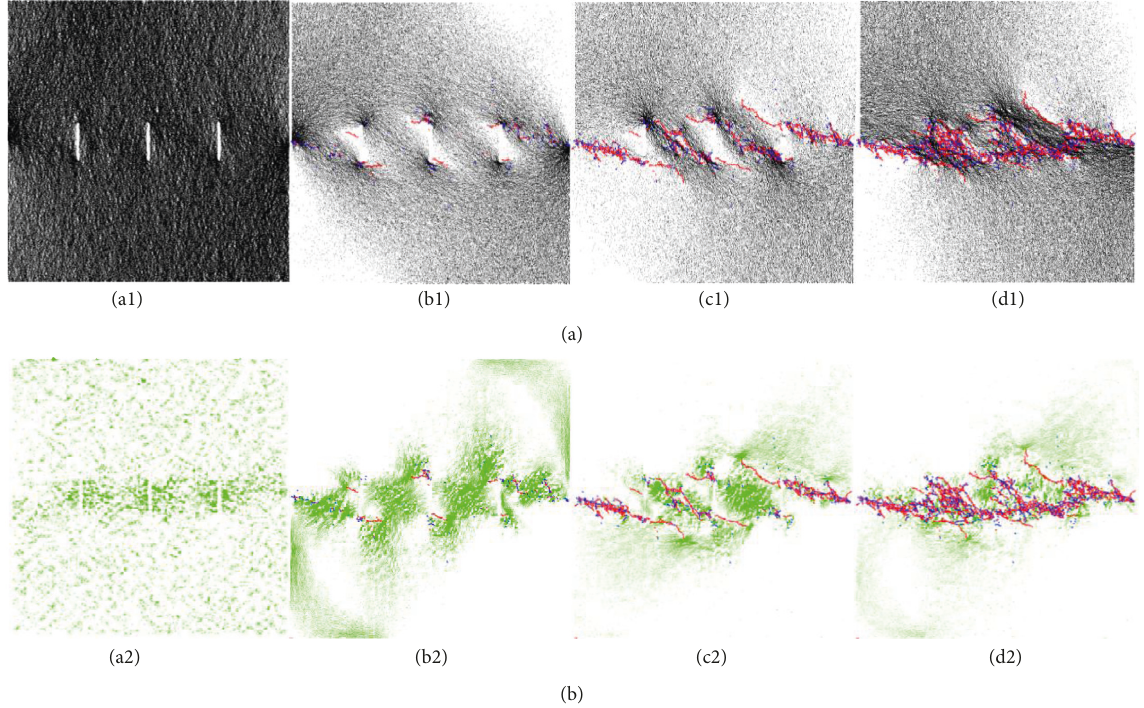
Figure 19: Contact force evolution of B90 (shear direction: left to right): (a) compressive contact force; (b) tensile contact